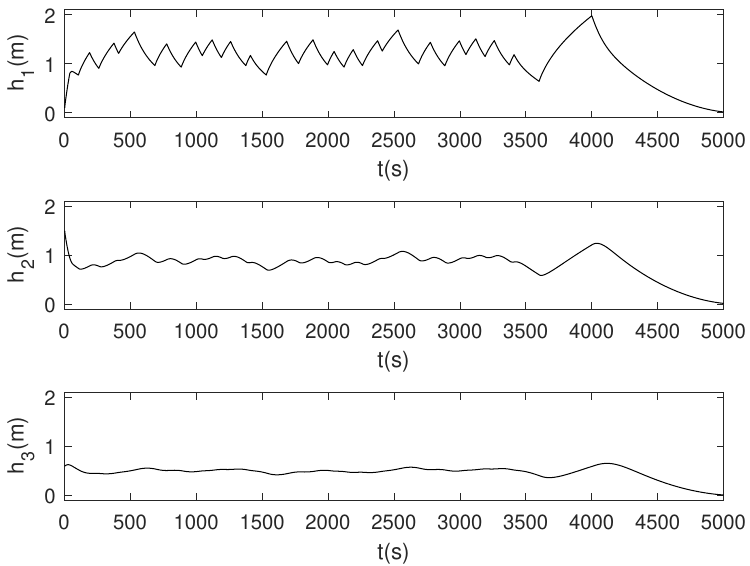
Figure 2. Three-tank system. Simulation results for the three state variables using real numbers. For the simulations using marks, all magnitudes are considered as marks whose centers are the former real numbers and granularities have been fixed to g = 0.00001, for all the marks. The levels of liquid into the tanks are influenced by perturbations and the dynamics of the inputs and outputs of liquid. Calling pr this variation, the tolerance can be calculated by t = pr / h . Taking pr = 0.10, the common tolerance for all the simulations is t = 0.05. Unlike the granularities, the tolerances have to be equal for all the marks. Results are shown in Figure 3 that contains the intervals associated to the marks, drawn in form of little vertical segments. Together, they are represented by the dark band of the figure. The run time for the t = 5000 s of the simulation is 200 s. In accordance with the semantic of marks (16) these results mean that, for one 219 instant, for example i = 500 (time t = 2500 s), the model outputs result in these marks 220 and related associated intervals 221